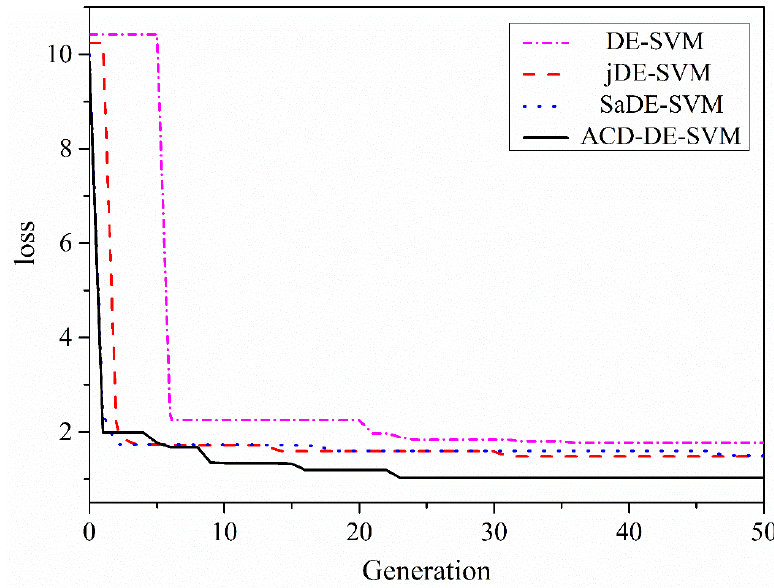
Figure 6. Fitness function curve under different optimization algorithms.